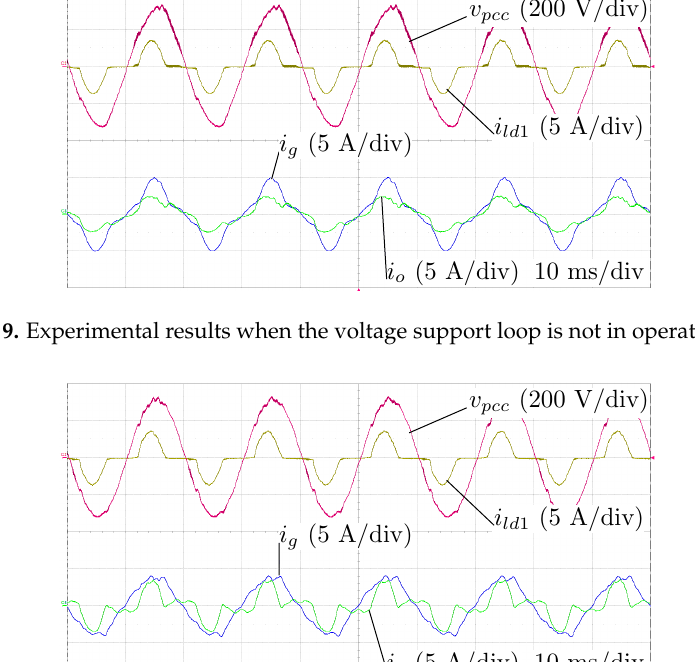
Figure 10. Experimental results when the voltage support loop is enabled, I ∗